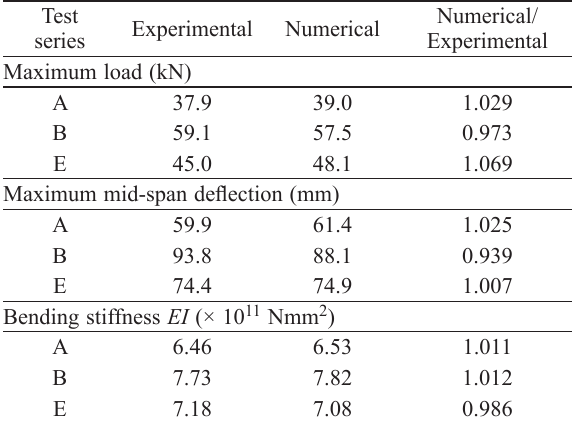
Table 8. Comparison between experimental results and numerical predictions